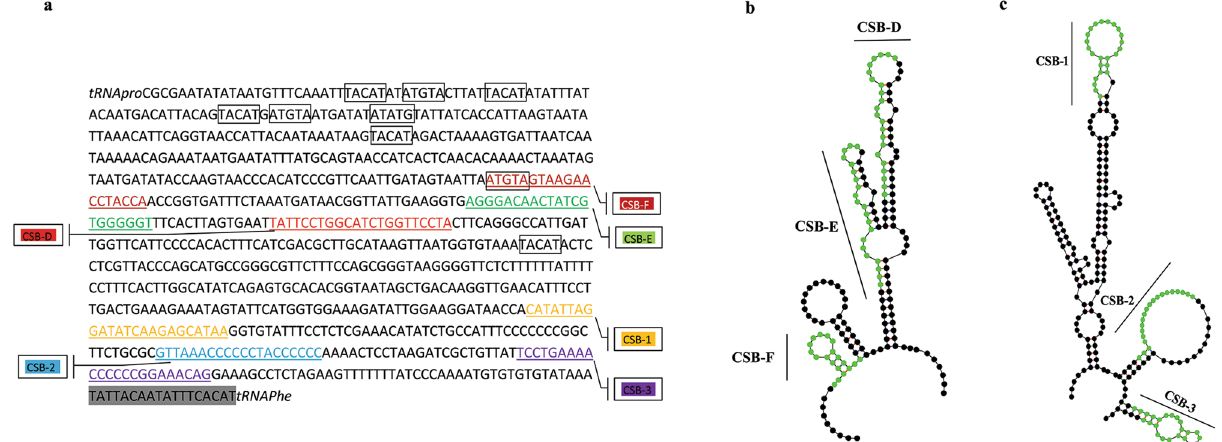
Figure 2. Sequence and structure of the mitochondrial DNA control region of carangids ( a ) Features of the control region. CSB-F,-D,-E: central conserved sequence blocks; CSB-1,-2,-3: conserved sequence blocks. Palindromic sequence motifs ’TACTA’ and ’ATGTA’ are framed. Grey colored bar represents the characteristic 3’ terminal sequence. ( b ) The secondary structure identified in CSB-F, CSB-D, and CSB -E. ( c ) Secondary structure identified in CSB-1, CSB-2, and CSB-3. The secondary structures of conserved sequence motifs were predicted by the online Mfold web server (http:// www. unafo ld.